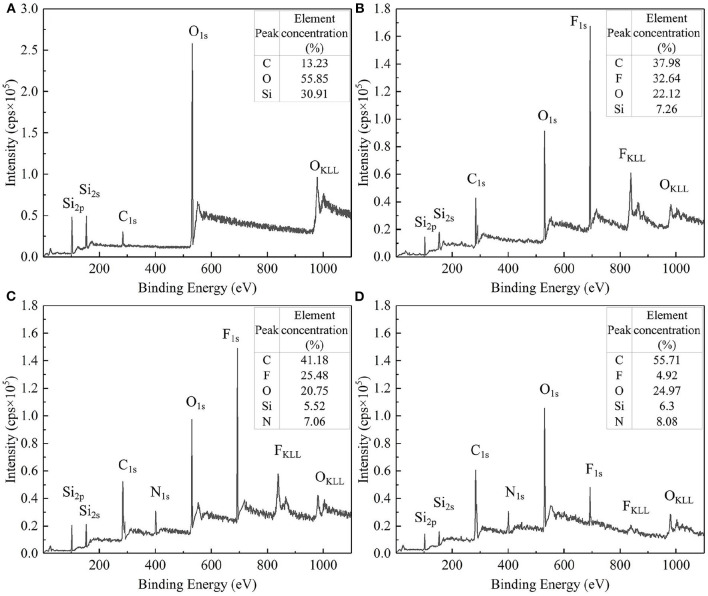
XPS full spectrum and relative element concentration. (A) Bare silica particles; (B) Uniformly modified particles; (C) JP1s; (D) JP2s.